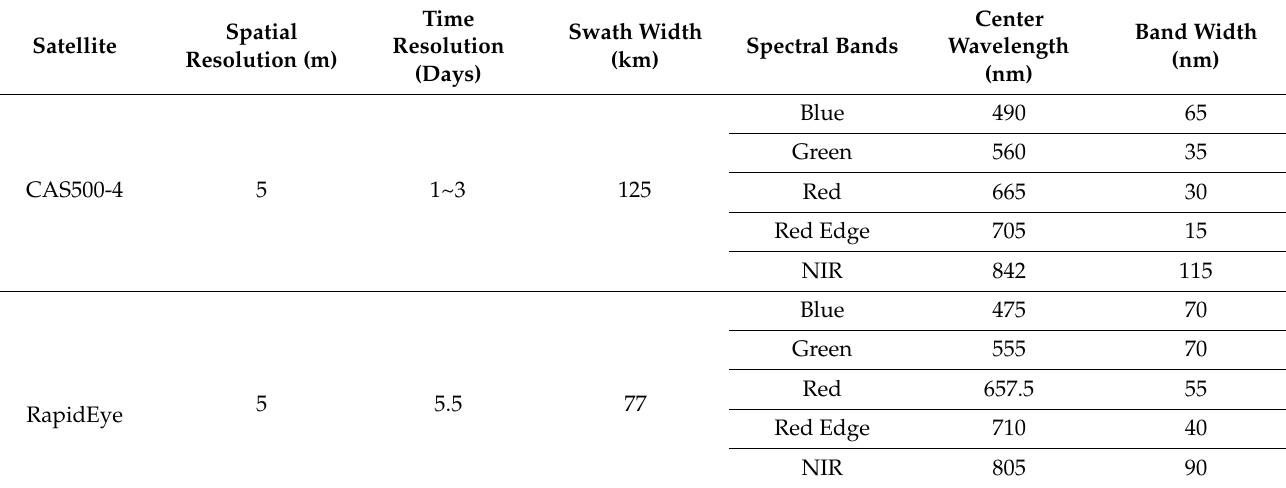
Table 1. Comparison and information of satellites’